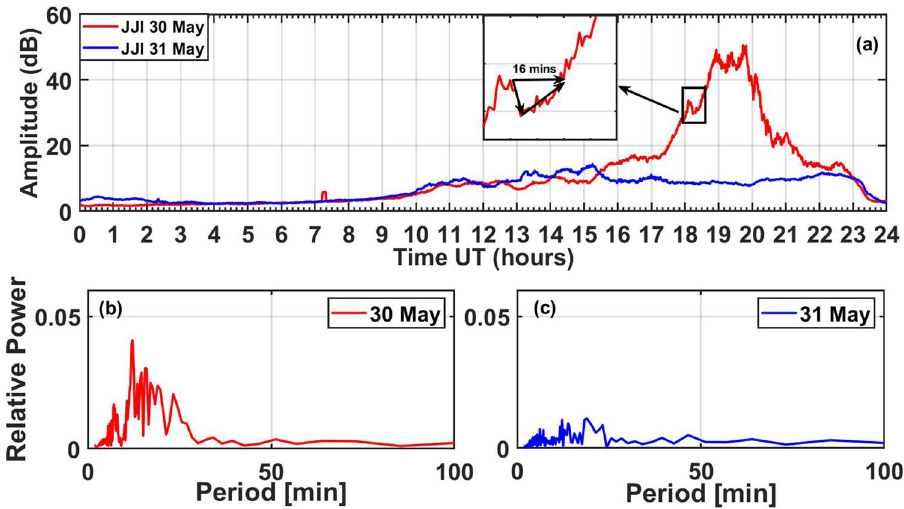
Figure 5. ( a ) JJI (22.2 kHz) VLF signal amplitude variation on 30 and 31 May 2014 with red and blue colors, respectively. The inset shows the zoomed of signal drop-in and recovery at the sprite occurrence time. ( b ) FFT of the JJI signal filtered amplitude during 17–20 UT on 30 May 2014. The highest peak shows dominant frequency ~ 12.2 min. ( c ) FFT of the JJI signal filtered amplitude during the same period on 31 May